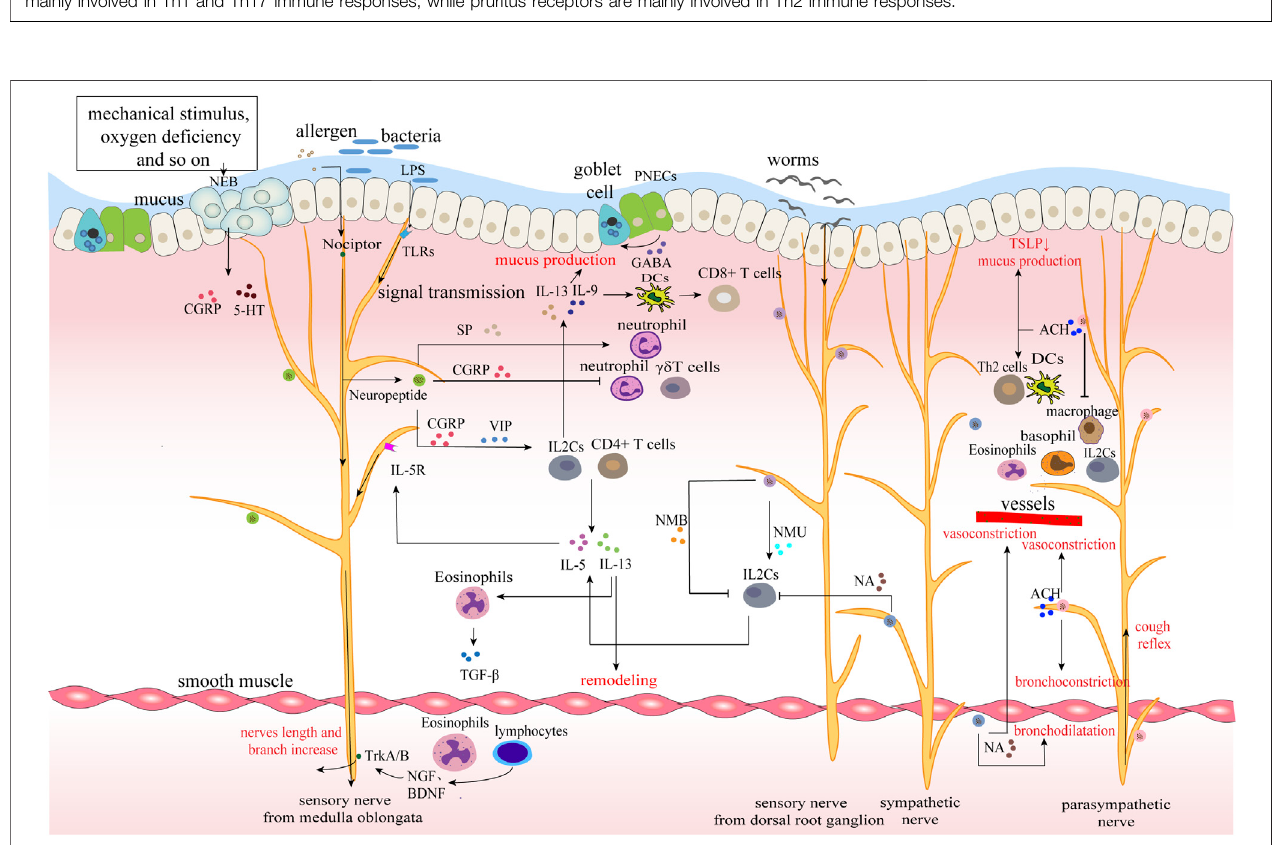
FIGURE 2 | Neuroimmune circuits in lungs. The epithelium, nerves and immunity of the lung together constitute the airway barrier. Various allergens, bacteria and parasites stimulate and interact with different nerves to upload signals and regulate immunity. For example, LPS of bacteria combines with TLRs of sensory nerves to promote the release of neuropeptides, while worms act on sympathetic nerves to secrete neurotransmitters and mainly regulate ILC2s. Immune cells transmit immune signals tothenerve byreleasingcytokines, forming aclosed-loopofnerve and immunity.Moreover,immunecellssynthesize nerve growth factor topromote nerve growth and increase nerve exposure in the airway.